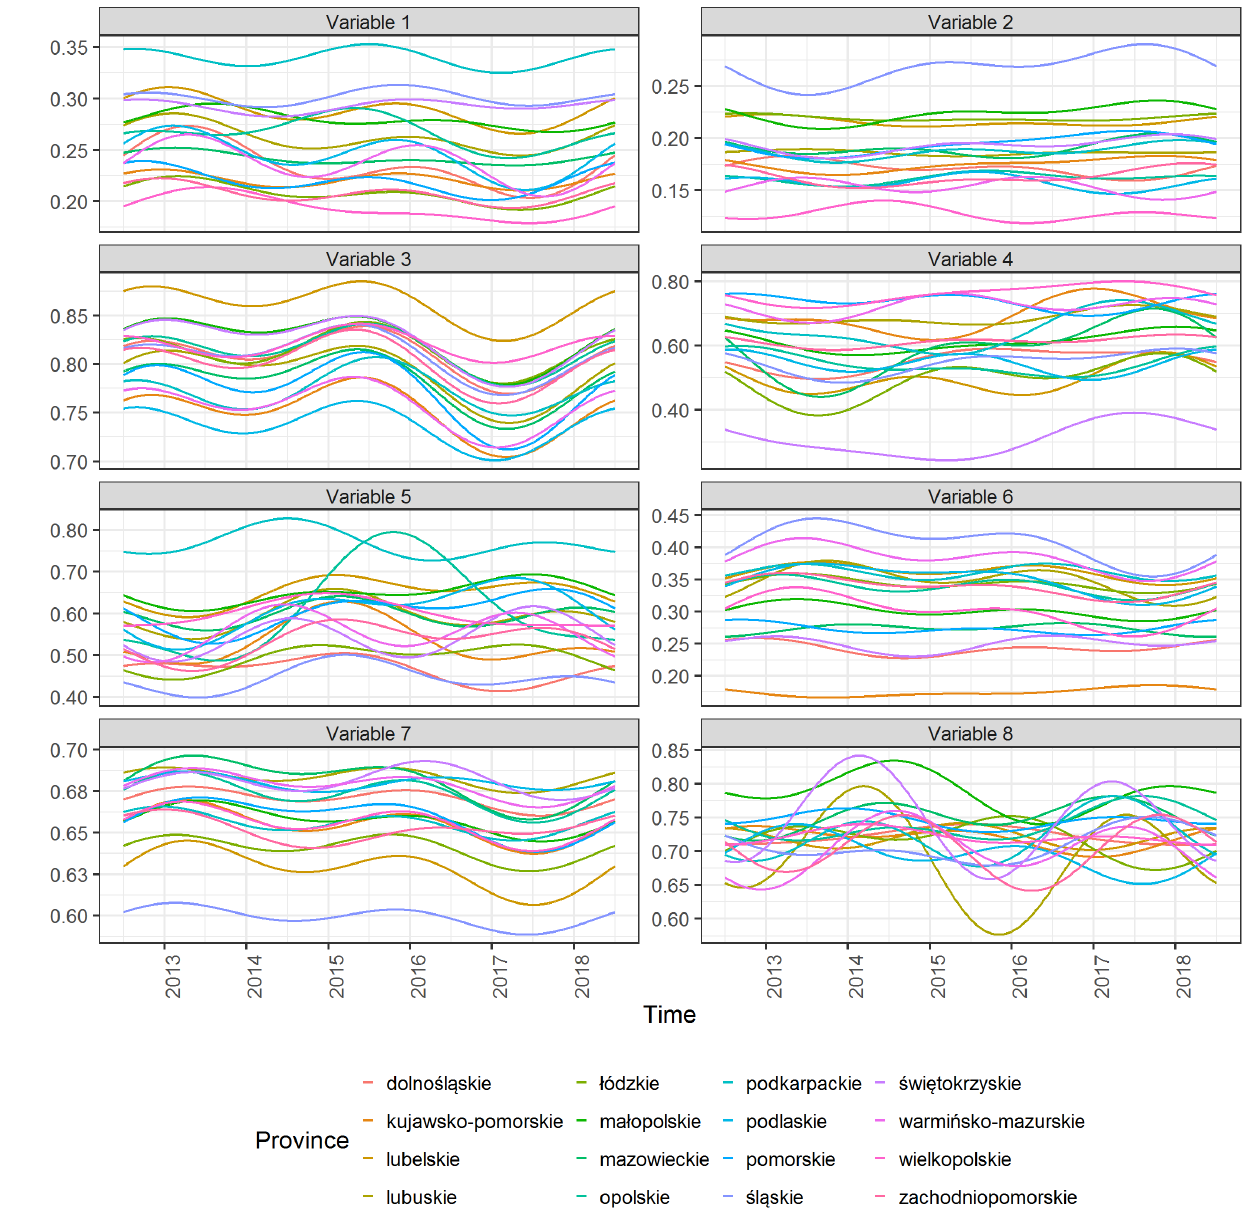
Figure 2. Average values of 8 variables calculated from functional data for districts included in each of the 16 provinces. Note: The ordinate axis shows the unitized values of a given